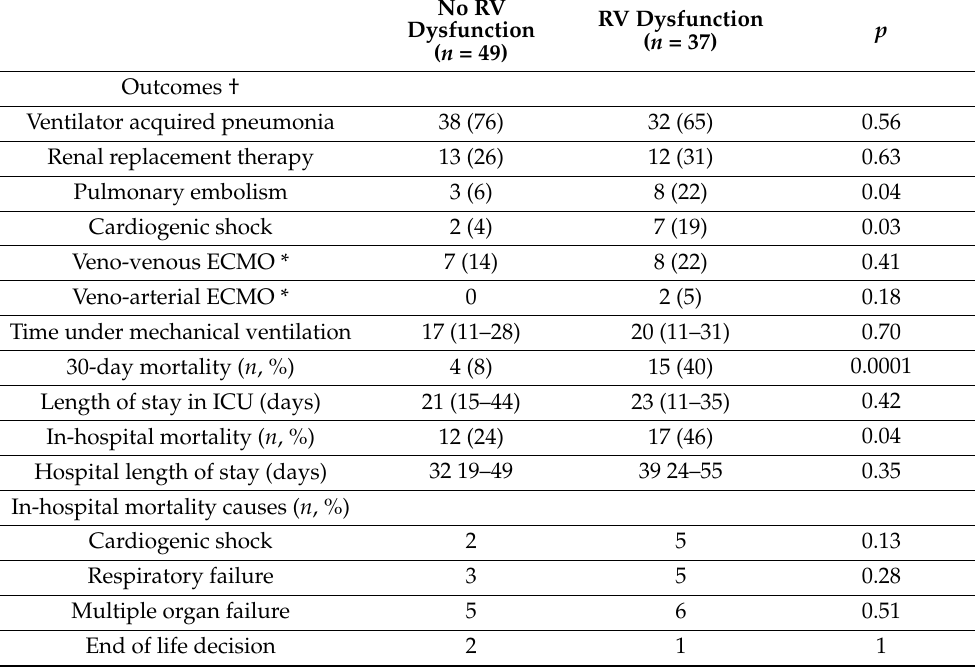
Table 3. Clinical outcome during ICU